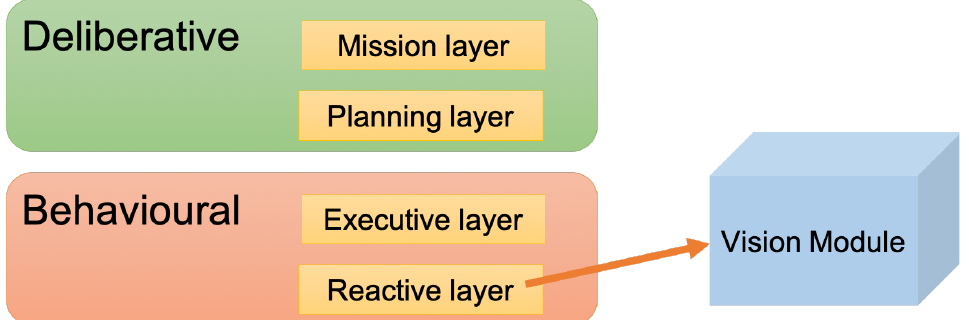
Figure 1. MERLIN architecture and proposed vision